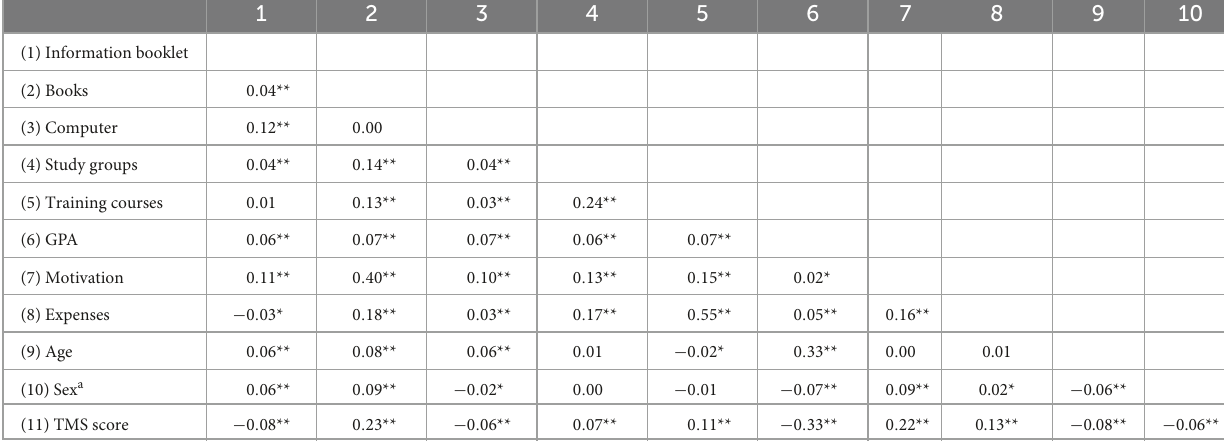
TABLE 4 Pearson correlations of all predictors in the final regression